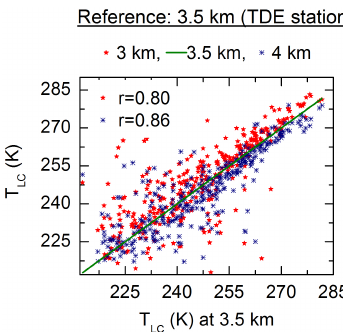
Figure C1. A 3-year (2012–2014) analysis of the uncertainty in the vertical resolution of the model using TDE as reference station. The correlation between T LC at 3500m with 3000 and 4000m respectively, is shown.